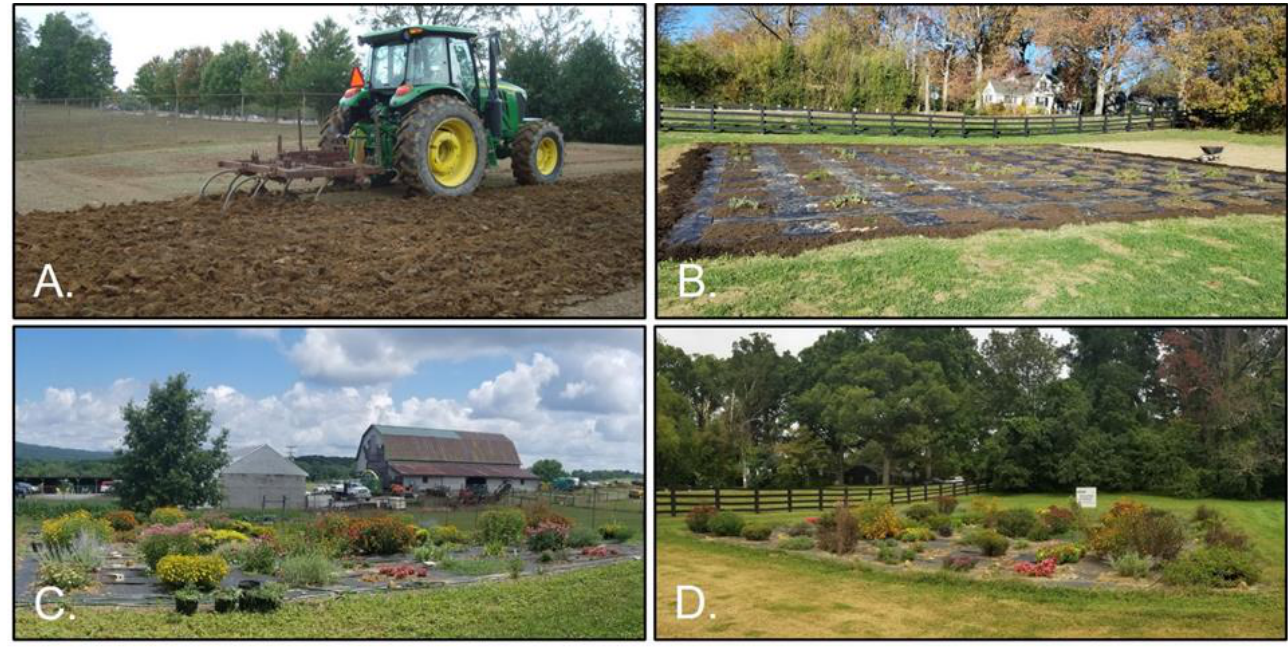
Figure 1. We conducted our study in two experimental gardens located in Blacksburg, Virginia, USA, approximately 4.8 km apart. At both sites, we ( A ) chisel plowed and tilled and ( B ) laid landscape fabric in a lattice to create 100 square plots, so each of our 25 plants could be replicated four times. Photo ( C ) is the Urban Horticulture Center, or UHC, a month before data collection began in 2020, and photo ( D ) is the Turfgrass Research Center, or TRC, a month after data collection ended in 2021.